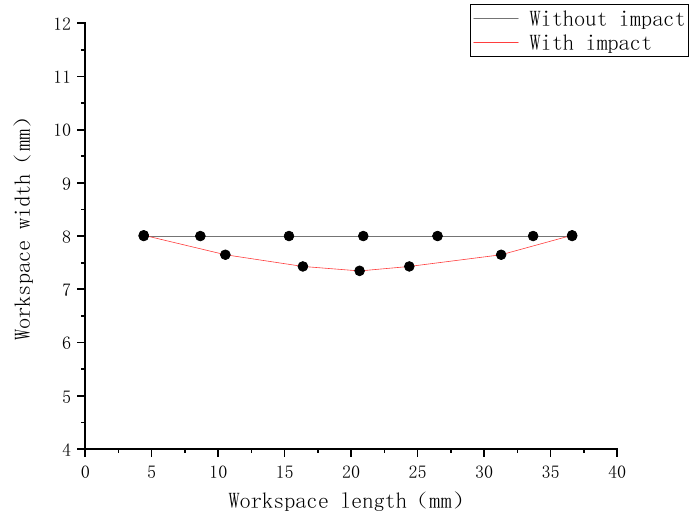
Figure 3. Comparison of deformation results of specimens of dissimilar lightweight materials welded joints along the width direction.